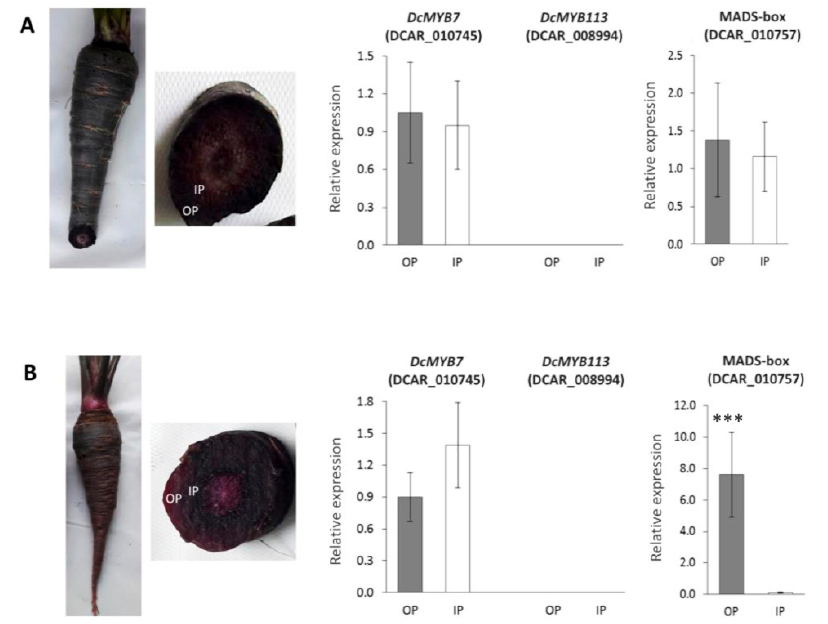
Figure 3. Gene expression analysis (RT-qPCR) of DcMYB7 , DcMYB113 and MADS-box (DCAR_010757) in the root purple outer phloem (OP) (gray bars) and purple inner phloem (IP) (white bars) of the carrot inbred line P9547 ( A ), which is genetically related to 3242, and the Indian cultivar Pusa asita ( B ). Root phenotypes with cross-sections indicating the OP and IP tissues, and their gene expression profiles are presented. Bars indicate mean values for the fold change in gene expression relative to the expression of the internal control gene (actin), as calculated from the ratio ∆ Cq-target gene/ ∆ Cq-actin [34], and their standard errors. Asterisks (***) indicate signifi- cantly higher gene expression at p < 0.001, whereas OP vs. IP comparisons without asterisks is not statistically different at p ≤ 0.05. The absence of bars for DcMYB113 indicates that no transcripts were detected.